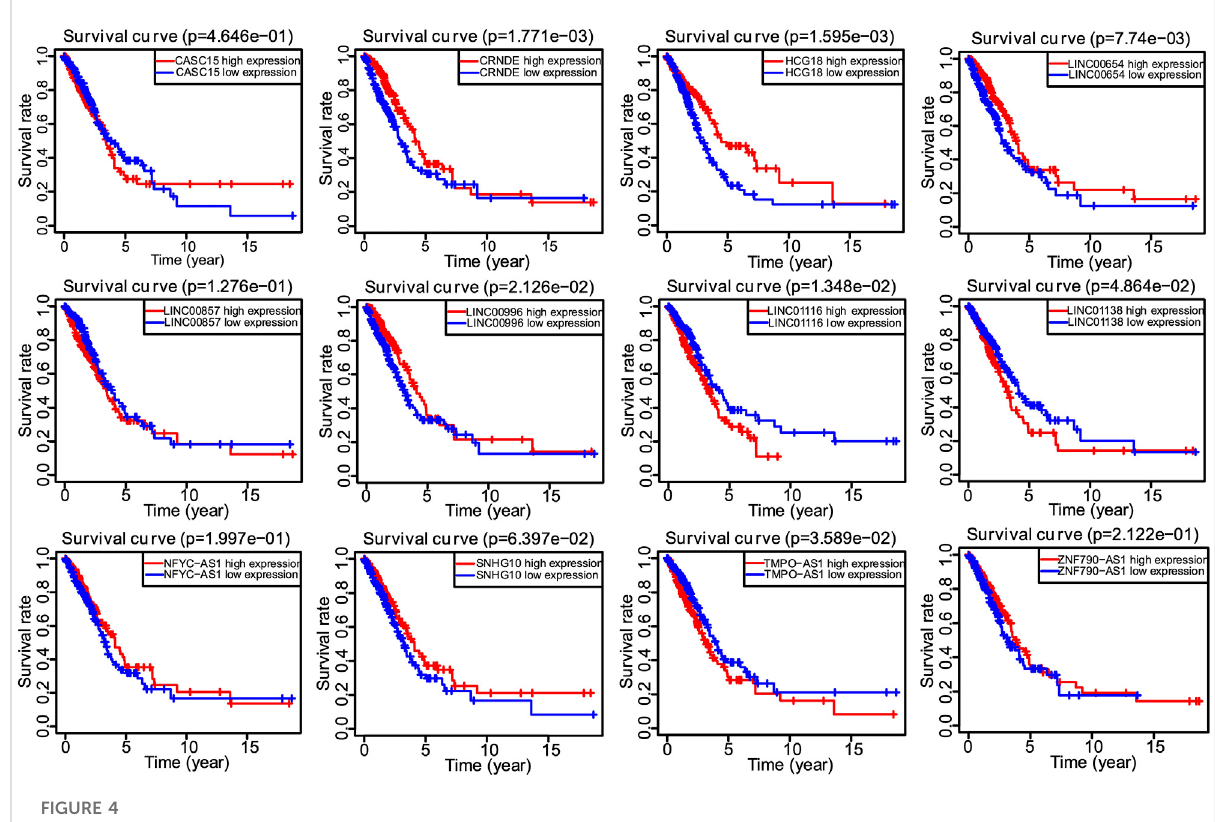
FIGURE 4 The Kaplan – Meier survival analysis of 12 screened lncRNAs.